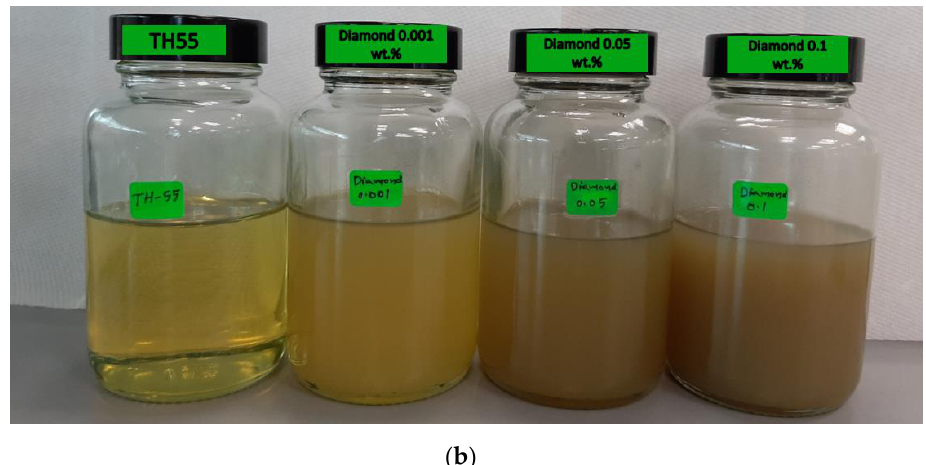
Figure 1. ( a ) Schematic of Two-step Nanofluid Formulation method, ( b ) Formulated TH-55/DP stable nanofluid at different concentrations.